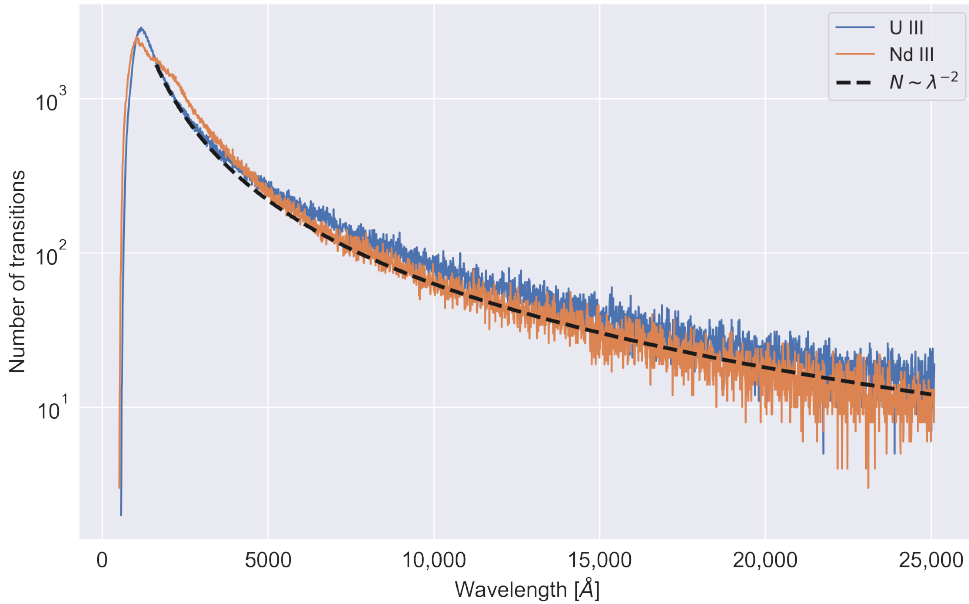
Figure 5. Total number of lines for Nd III and U III as a function of the wavelength. The N ∼ λ − 2 inverse power law dependence on the wavelength is highlighted. A wavelength bin of ∆ λ = 10 Å was